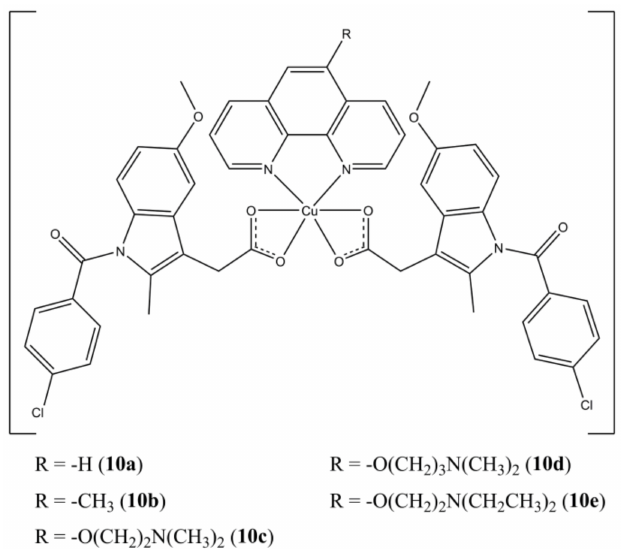
Figure 10. Structures of the [Cu(indomethacin) 2 (5-Rphen)]